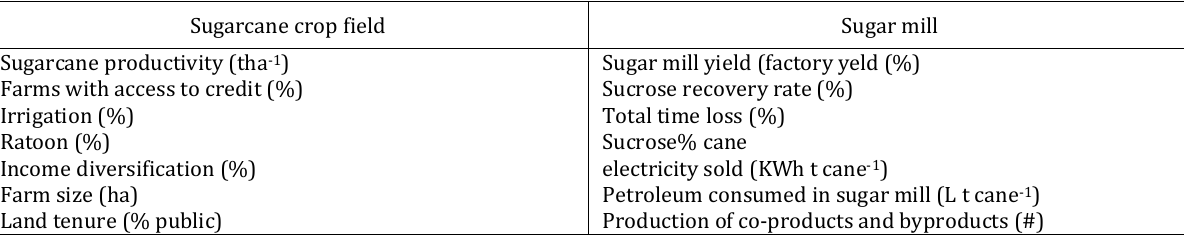
Table 2. Diversification index factors (Aguilar-Rivera,